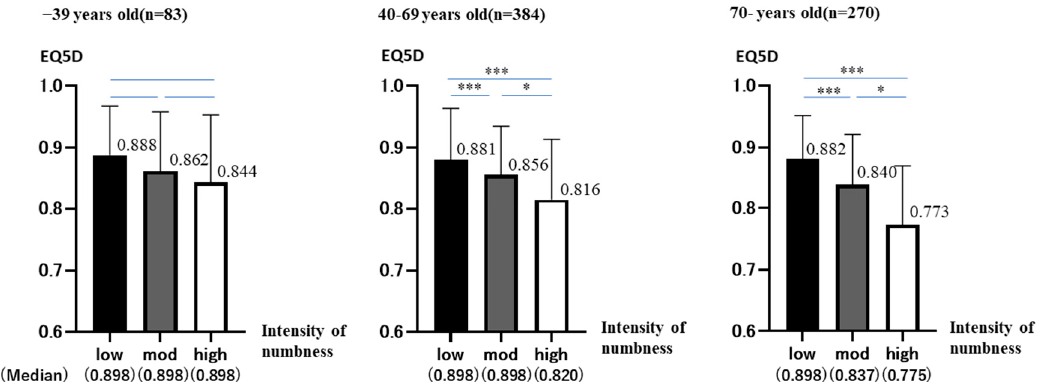
Figure 4. The analysis was divided by age group into 39 years or younger, 39–69 years, and 70 years or older. EQ5D is on the vertical axis, and numbness intensity is on the horizontal axis. The graph shows the mean and standard deviation (95%CI) of EQ5D in each group. ( p < 0.05 *, < 0.001 ***).